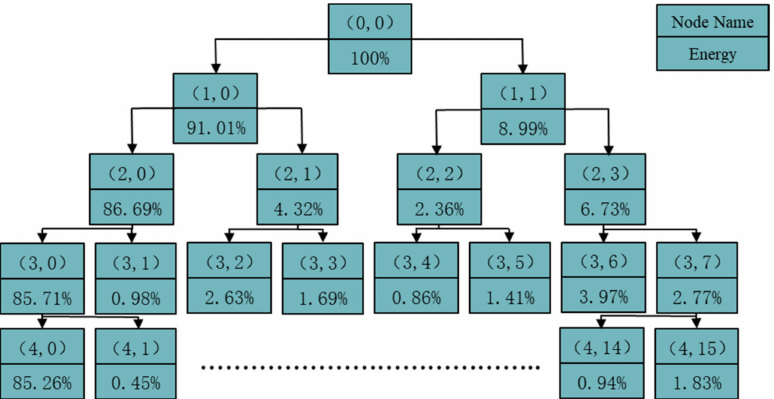
Figure 5. Wavelet packet decomposition node and energy